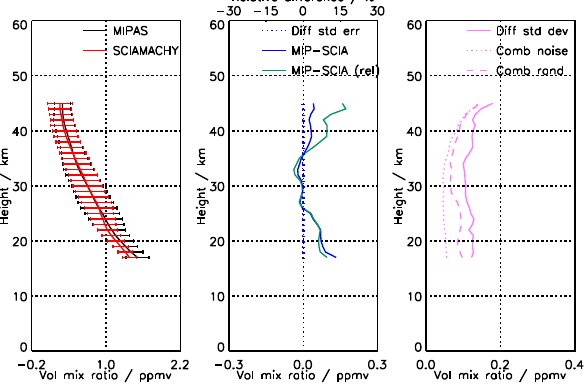
Figure 13. Comparison of N 2 O from ACE-FTS and MIPAS full resolution (V5H_N2O_21). Details as in Fig.